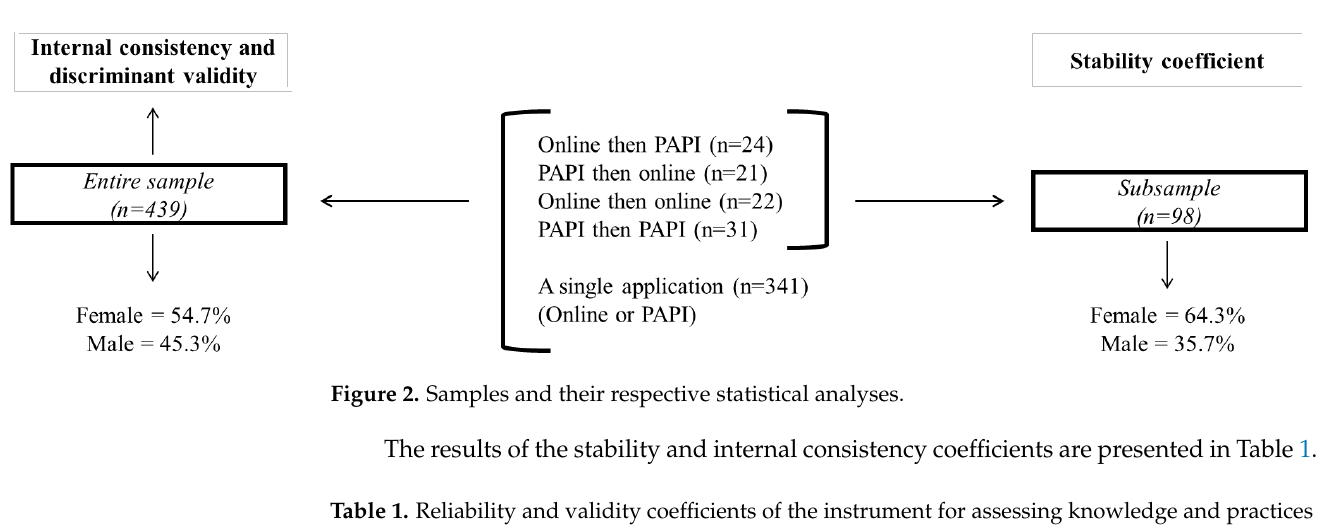
Table 1. Reliability and validity coefficients of the instrument for assessing knowledge and practices related to food safety.